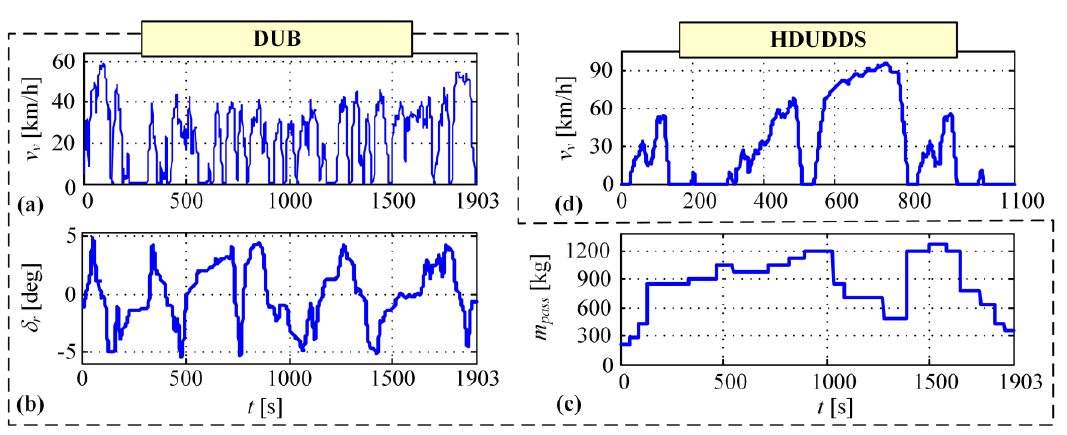
Figure 4. City bus driving cycle including vehicle velocity ( v v ) ( a ), road grade ( δ r ) ( b ), and passenger mass ( m pass ) ( c ) time profiles recorded in the city of Dubrovnik (DUB); and velocity time profile for heavy-duty UDDS driving cycle (HDUDDS) which assumes a zero road ( d ).